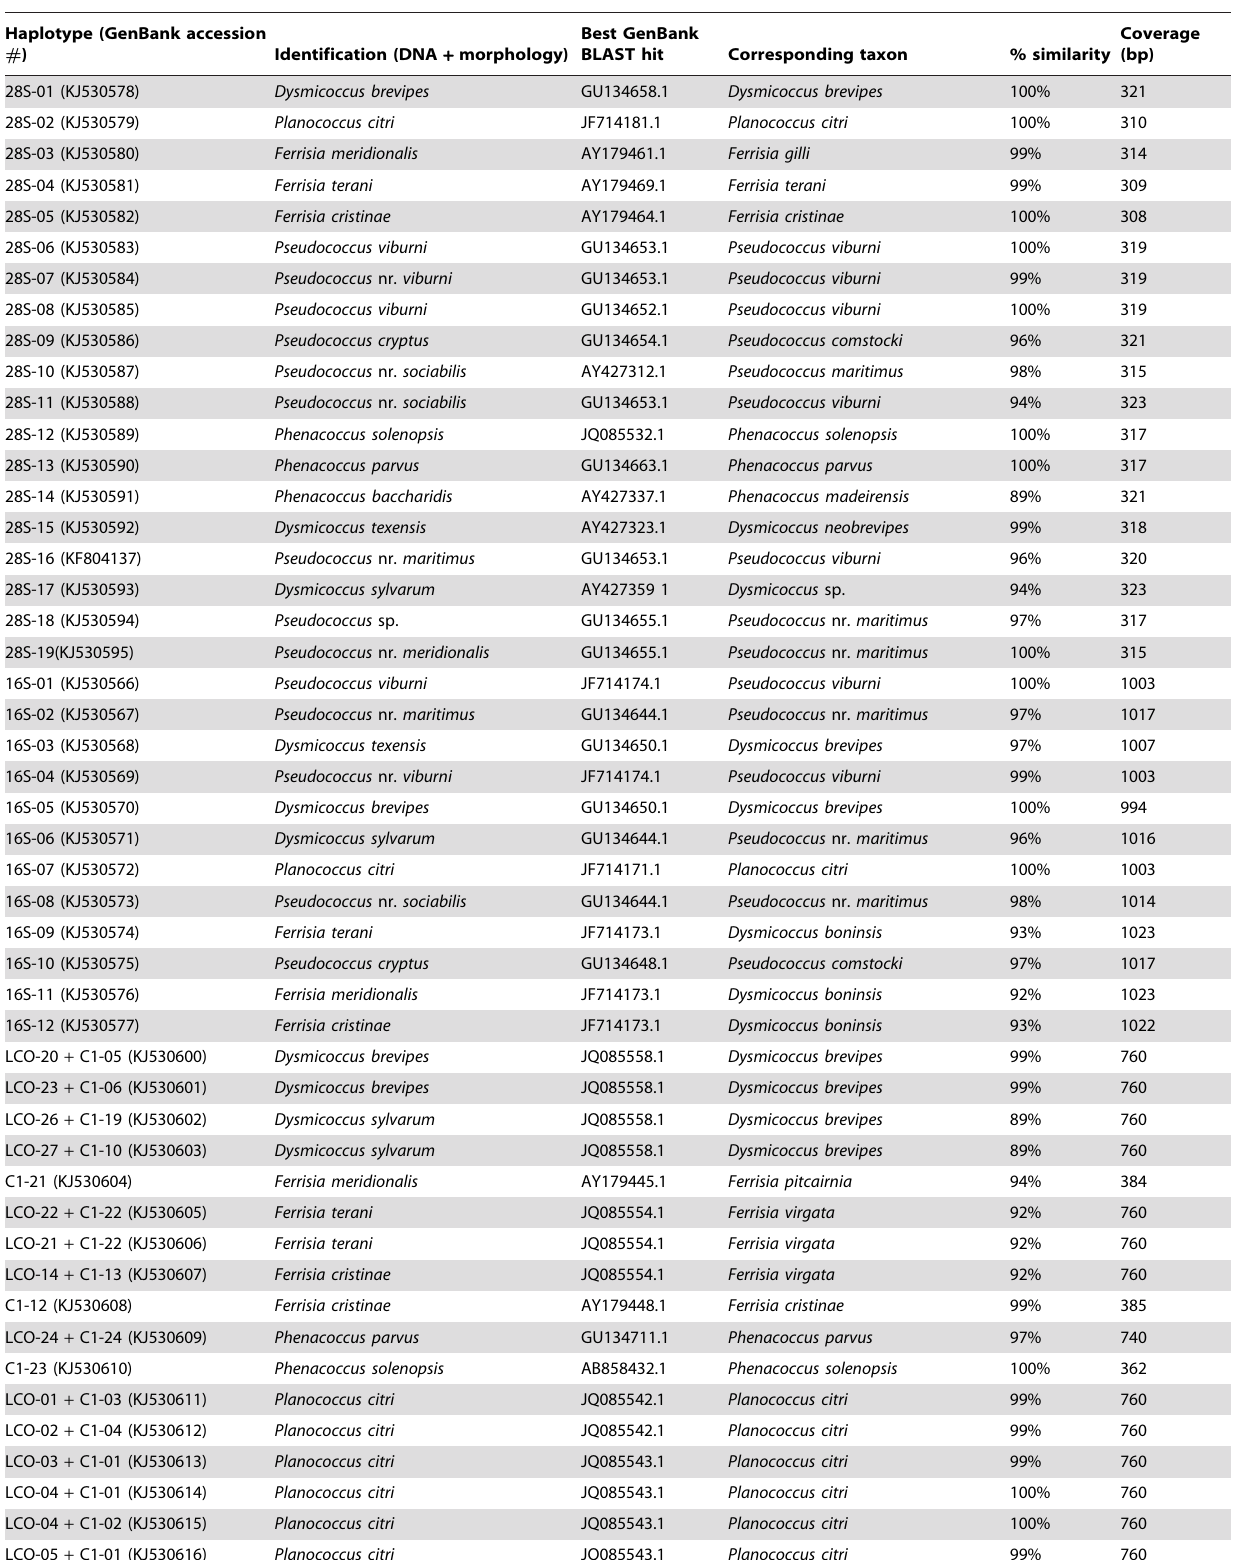
Table 2. GenBank accession number, Blast Hits, corresponding taxon, % similarity and coverage between the Brazilian mealybug sequences and sequences from the NCBI GenBank